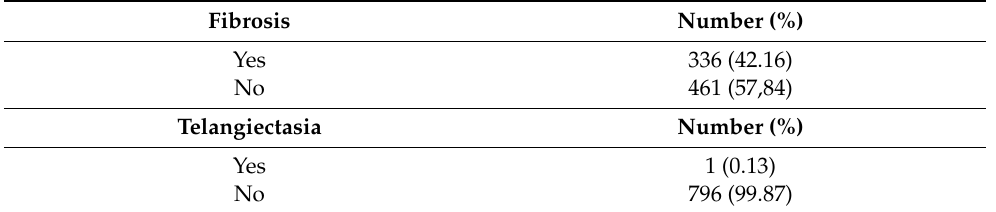
Table 5. Late toxicity after Intra-Operative Electron Radiation Therapy and Whole Breast Irradiation (IOERT + WBI) according to Common Terminology Criteria for Adverse Events (CTCAE) version